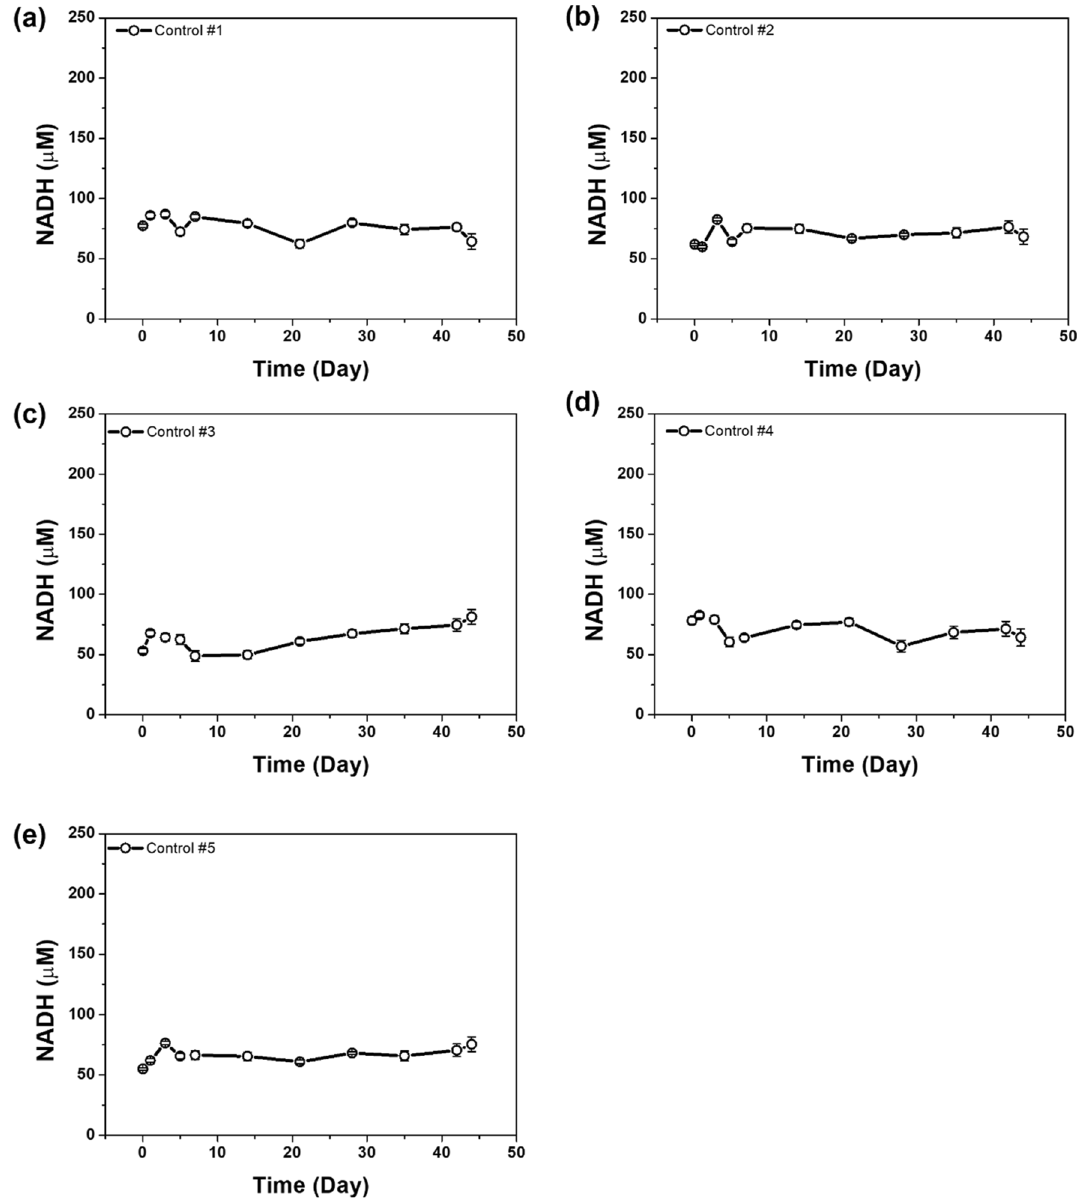
Figure 5. NADH profiles of the control groups as obtained using an electrocatalytic assay (n =